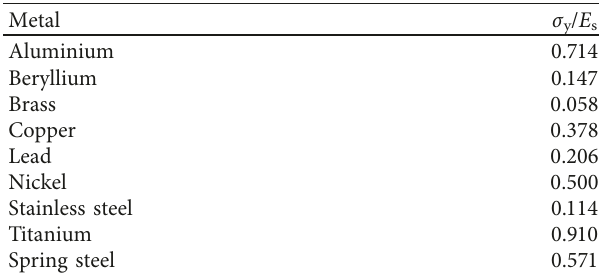
Figure 6: Influence of elastic modulus of the spring material. Table 3: Ratio of yield strength/Young’s modulus for various metals [14].